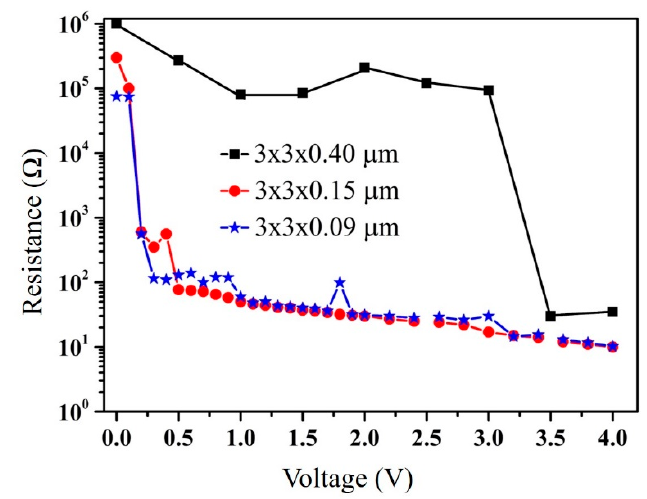
Figure 5. Effect of inter-electrode distance on Joule heating induced crystallization in GeTe vertical resistors (same cross-sectional area).